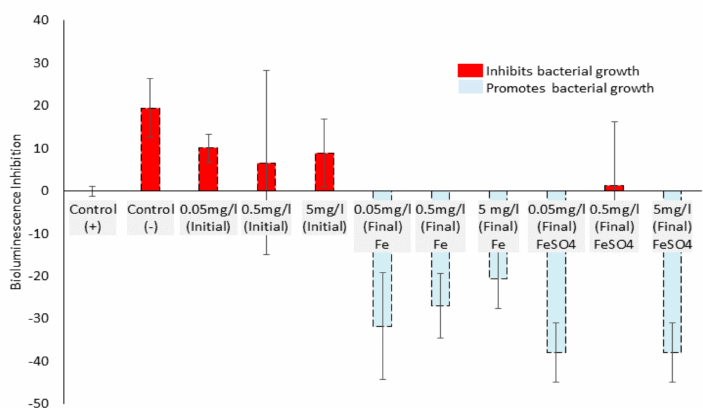
Figure 4. Microtox toxicity assay for untreated samples and by-products formed after the FeSO 4 and Fe Fenton oxidation treatment. Bioluminescence inhibition estimate the bacterial growth and above values are shown as % e ff ects on bacteria, evaluating toxic and non-toxic e ff ects of the